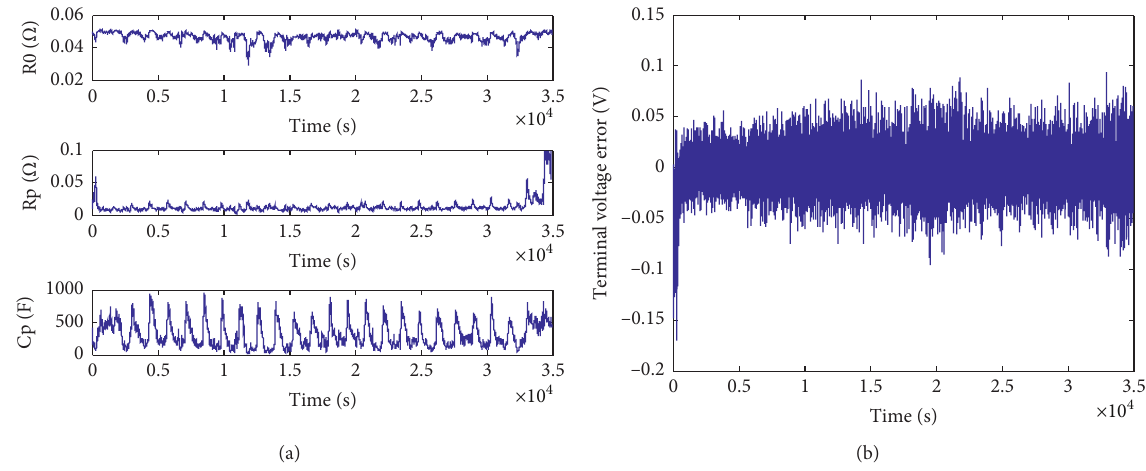
Figure 9: Model parameters identification results under FUDS: (a) R0 Rp Cp; (b) terminal voltage